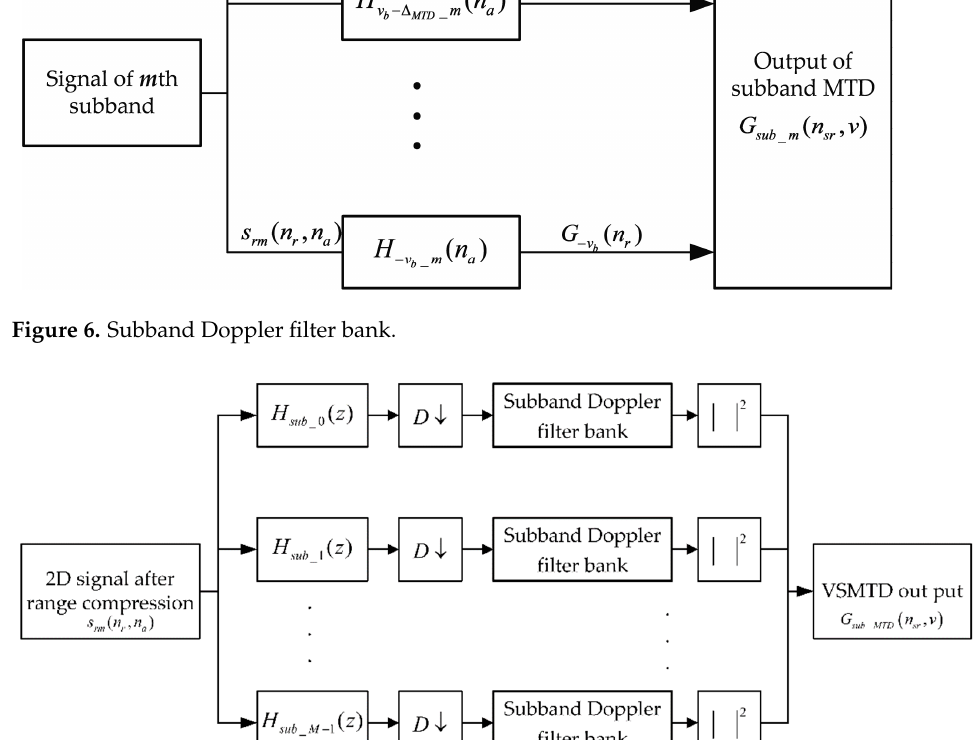
Figure 7. Variable-scale moving target detection filter bank.